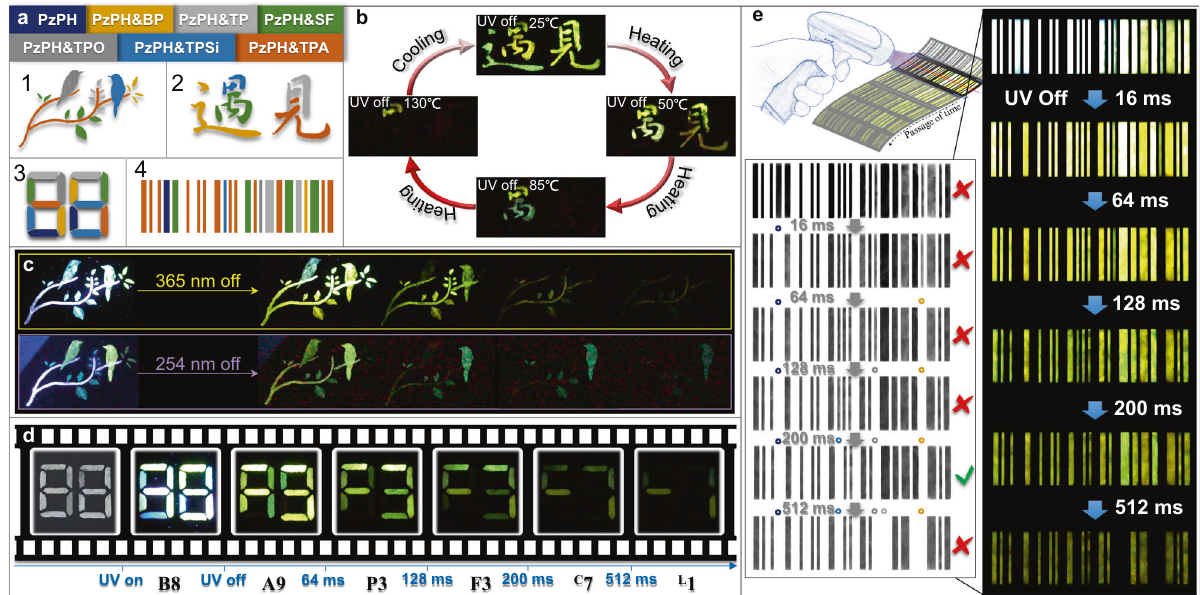
Fig. 4 Schematic illustrations of lifetime-order encoding for applications using the mH/G UOP system. a screen-printing patterns adopted for fl exible thin fi lms. b The UOP photographs taken after the stoppage of 365 nm excitation for thermosensitive anticounterfeiting by varying temperatures from 25 to 130 °C. c, d The UOP images along with duration time after the stoppage of UV light irradiation with different wavelengths (254 nm or 365 nm for c , and 365 nm for d ). e Dynamic afterglow bars with different duration time for higher-level information